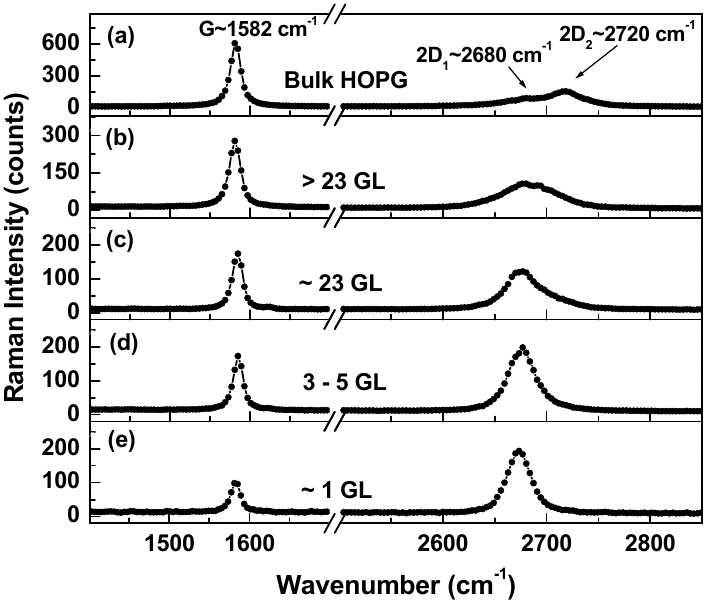
Figure 1. ( a – e ) Raman spectra recorded in different spots showing the behavior of the G and 2D bands for a single-layer, a few-layers, and multi-layer graphene. The Raman spectrum of bulk HOPG is also presented for comparison.